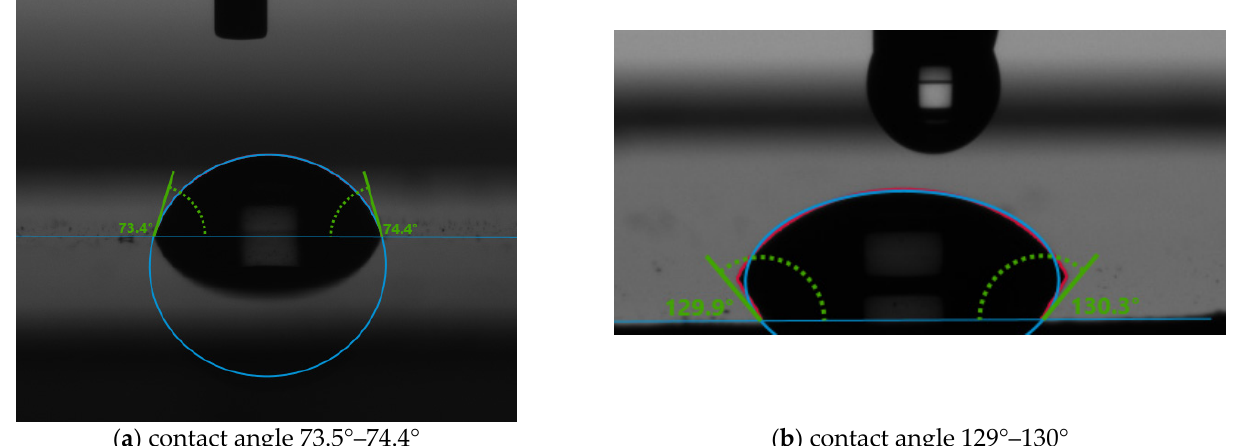
Figure 2. The contact angle of 2.5% PVA on Kapton ( a ) without plasma treatment and ( b ) with plasma treatment.